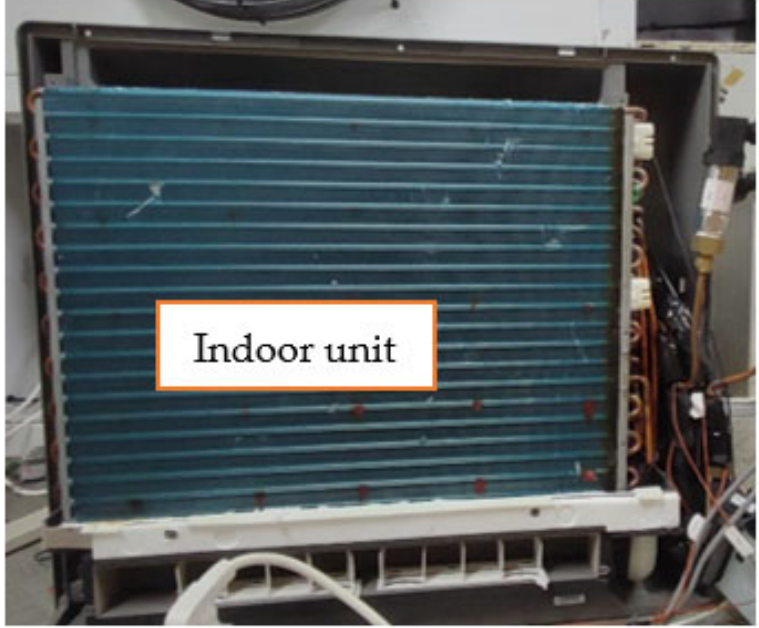
Figure 2. Physical picture of the indoor unit of the SC-EVIHP system.